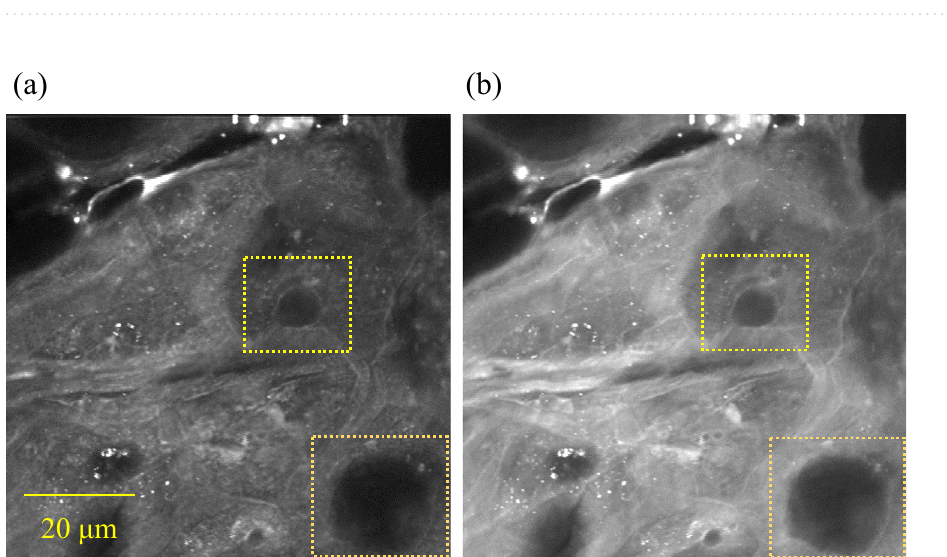
Figure 6. Molecular vibrational characteristics of holes in the stratum corneum. Optical cross-section images of an abdominal site of a 33-year-old Caucasian female at ( a ) 2850 cm − 1 and ( b ) 2930 cm − 1 are